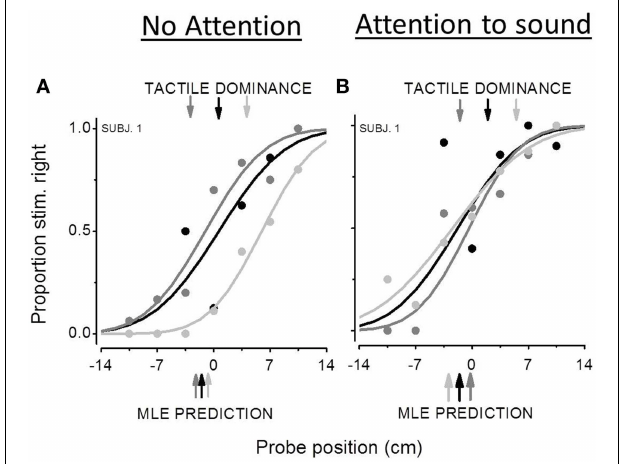
FIGURE 3 | Bimodal psychometric functions from the same participant in the non attentional condition (A) and in the attentional condition (B). The black curve represents subject’s performance in the 1 0 audio-tactile = conflict, the dark gray curve the performance in the 1 7 conflict and the = − light gray curve the 1 7 conflict. The x-axis represents the estimated = + position of the second stimulus by the QUEST algorithm (cm). Positive values of PSE mean a spatial bias to the left, while negative values a bias to the right. The lower color-coded arrows show the MLE prediction. The upper color-coded arrows indicate the predicted PSEs in the case of tactile